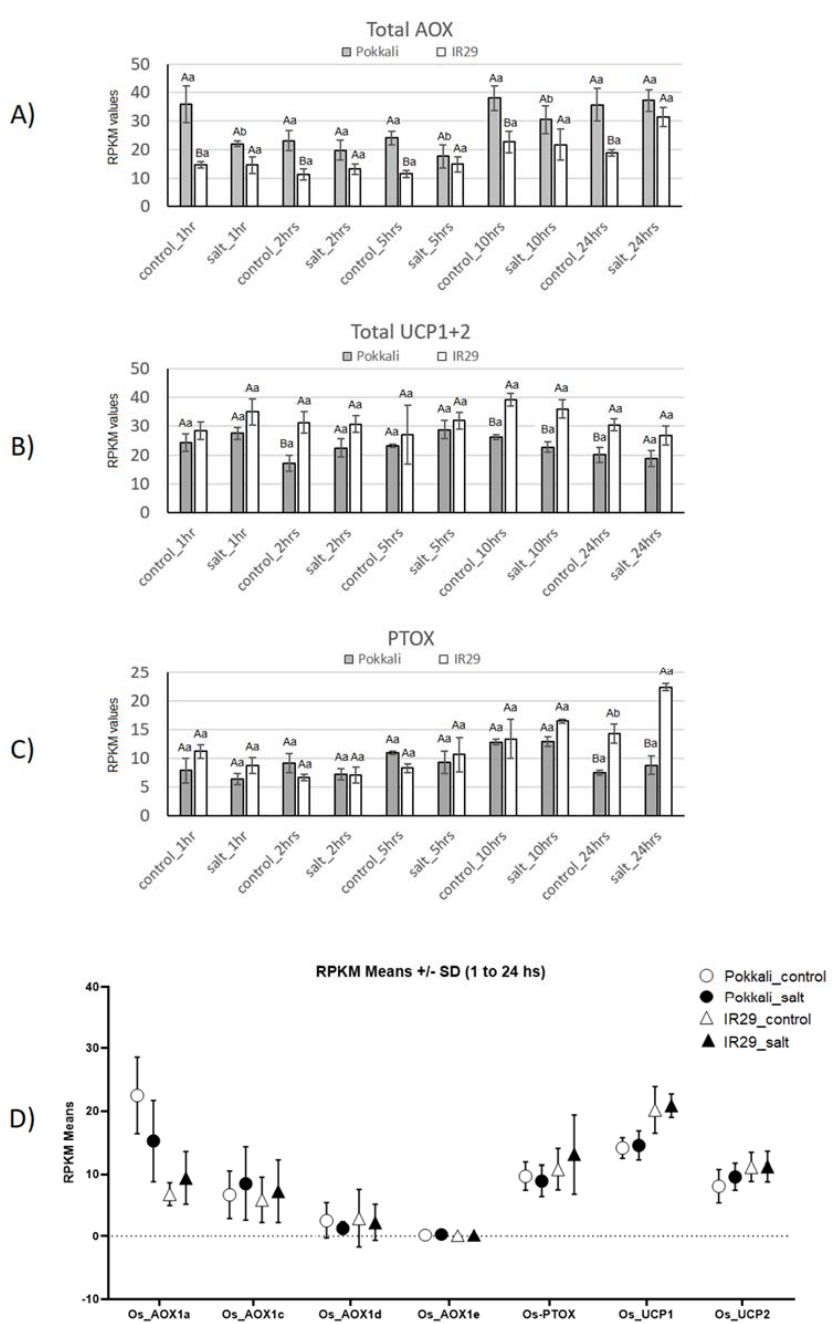
Figure 2. Expression profiles of Total AOX ( A ), UCP ( B ) and PTOX ( C ) genes in Pokkali and IR29 genotypes of Oryza sativa under salt stress. Data represent RPKM ( D ) means with standard deviations from 3 biolog-ical replicates. For each gene, different capital letters indicate significant differences (at p < 0.05) between genotypes (Pokkali and IR29), while lowercase letters designate significant differences between treatments (control and stress) at the same time point and genotype, according to Bonferroni’s test.